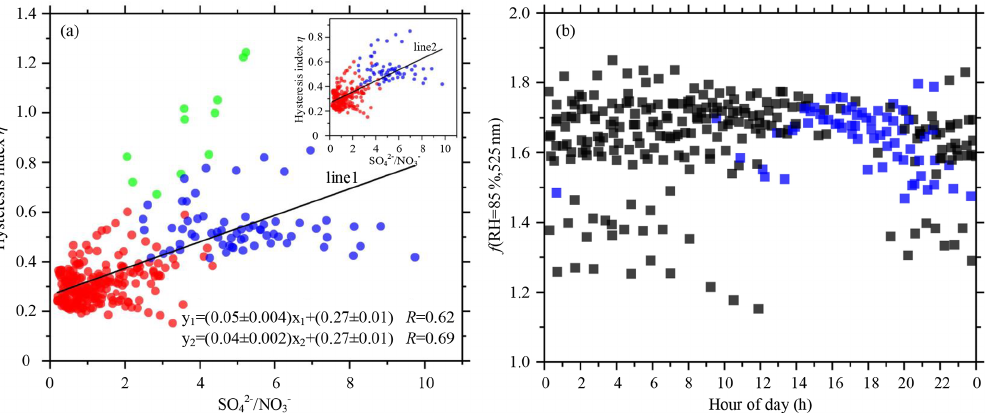
/ NO − mass concentration ratio. Blue dots represent deliquescence 4 3